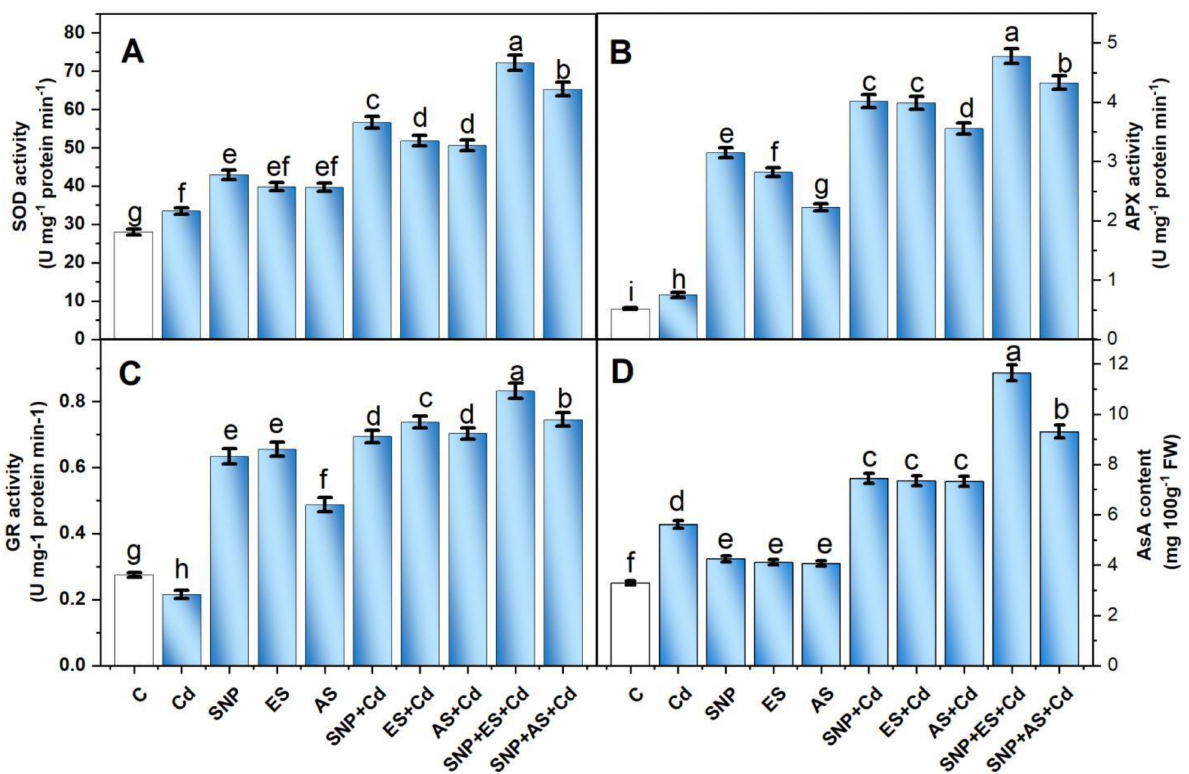
Figure 4. Activity of SOD ( A ), APX ( B ), GR ( C ), and content of AsA ( D ) in mustard ( Brassica juncea L. cv. Giriraj) treated with 100 µ M SNP (NO donor) and 200 mg S kg − 1 soil of elemental sulfur (ES) or ammonium sulfate (AS) in the presence or absence of 200 mg Cd kg − 1 soil at 30 days after sowing. Data are presented as treatment mean ± SE ( n = 4). Data followed by the same letter are not significantly different as determined by LSD test at p < 0.05. AsA, ascorbate; APX, ascorbate peroxidase; C, control; Cd, cadmium; cv., cultivar; GR, glutathione reductase; SNP, sodium nitroprusside; SOD, superoxide